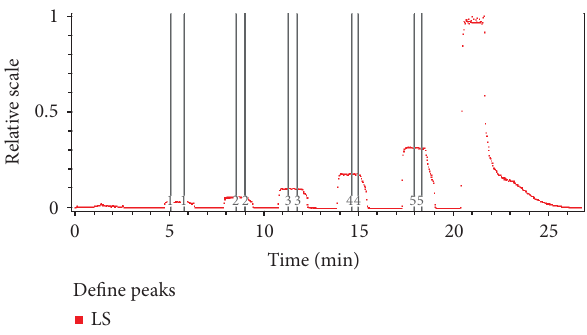
F 4: De�ne peaks of molecular weight of KGM by LLS.